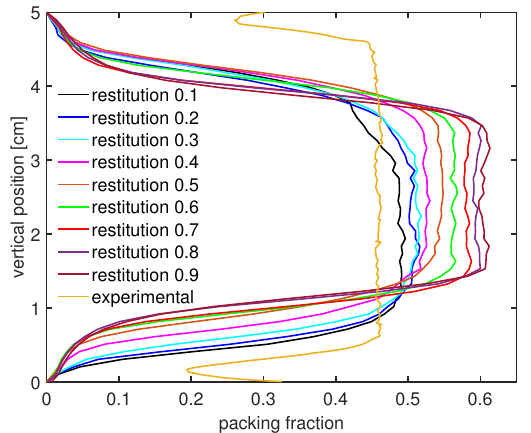
Figure 3. Numerical simulation using a frequency of 35 Hz and amplitude of 1 mm. The coe ffi cient of restitution was varied from 0.1 to 0.9 in the simulations. The corresponding experimental measurement in microgravity is shown in the graph.